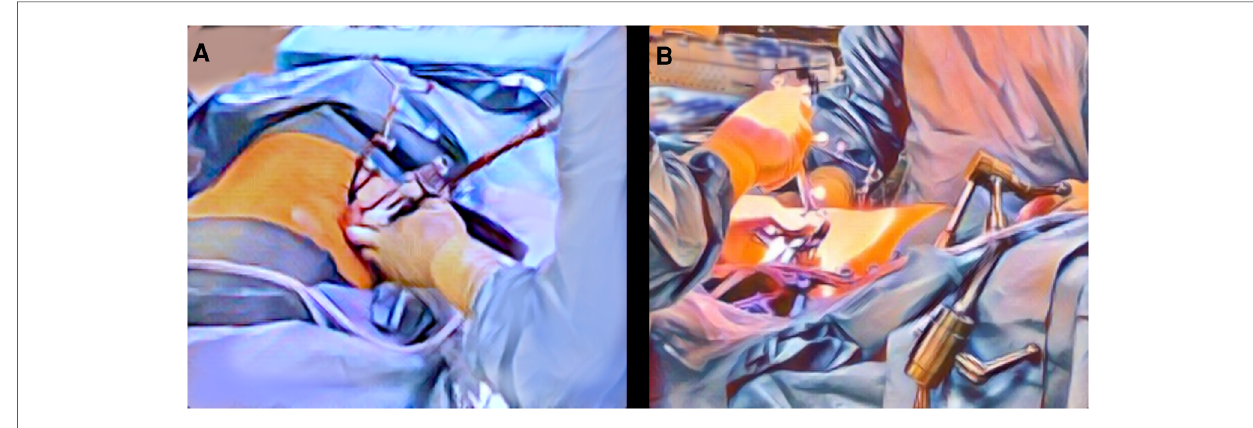
FIGURE 1 Patient positioning and setup. The patient is positioned semi-prone in a 45-degree right-sided positioning to enable suf fi cient surgical access for both surgical steps — navigated pedicle screw placement ( A ) and lateral discectomy and fusion ( B ). For referencing during surgery, a registration array is attached to a pelvic or spinal process. The surgical sites for pedicle screw placement ( A ) and lateral interbody fusion ( B ) are illustrated.